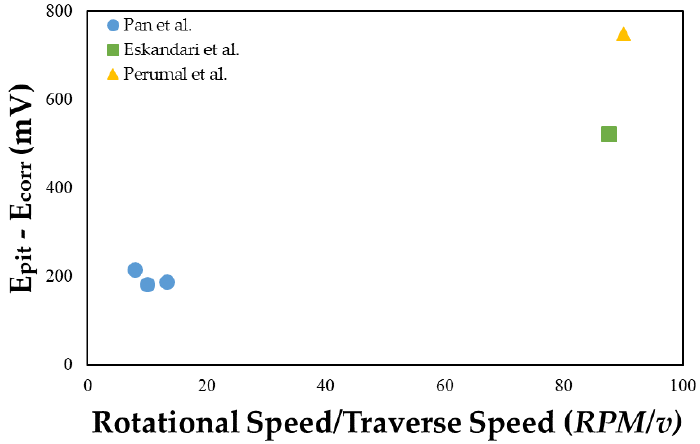
Figure 11. The pitting resistance of steel as a function of the ratio of rotational speed and traverse speed adapted from the work of Pan et al., Eskandari et al., and Permulal et al. [111,113,114].